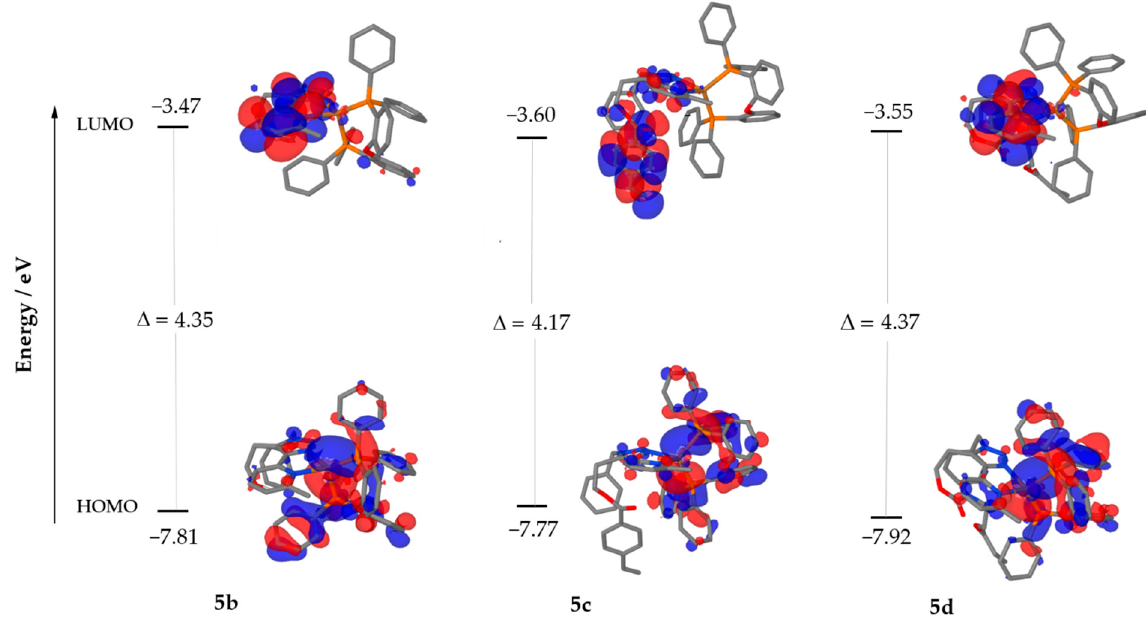
Figure 6. Isovalue contours calculated for the HOMO and LUMO of 5b ( left ), 5c ( centre ) and 5d ( right ). Hydrogen atoms are omitted for clarity. Red indicates the negative and blue the positive sign of the wave-function.